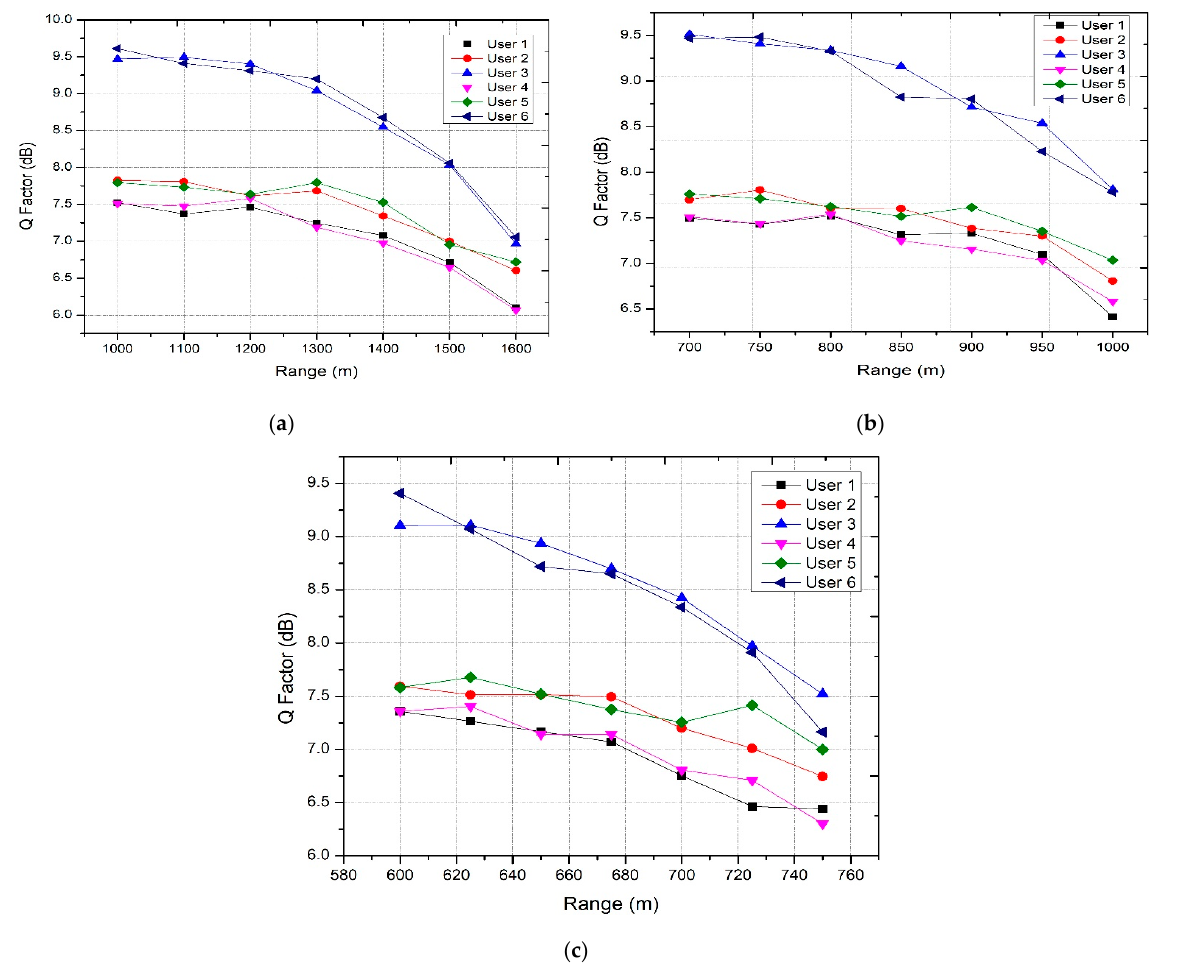
Figure 7. Q-factor for PDM-SAC-OCDMA-enabled FSO transmission versus range under ( a ) LF, ( b ) MF, ( c ) HF weather.